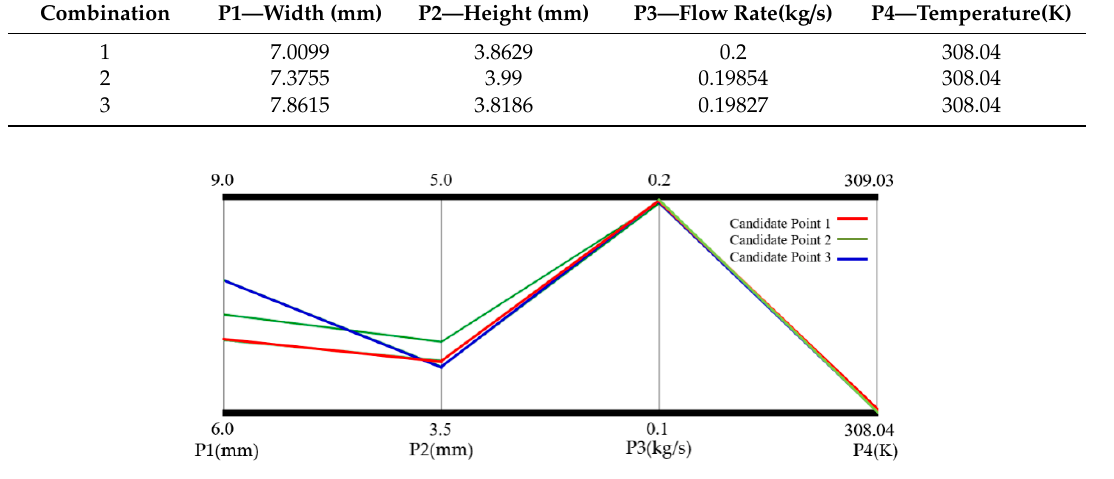
Table 7. Comparison of optimal dimensions of front bearing cooling channel. No.